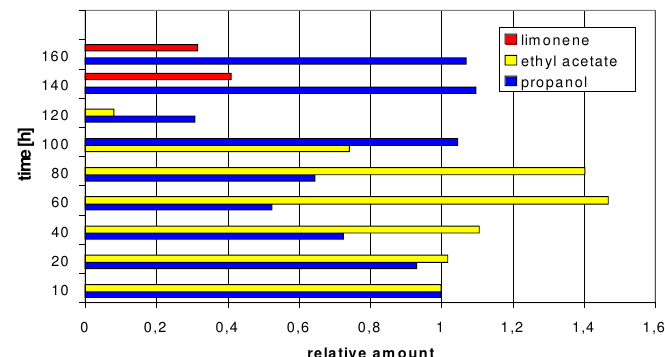
Figure 4. Trends for three key analytes obtained by an artificial neural